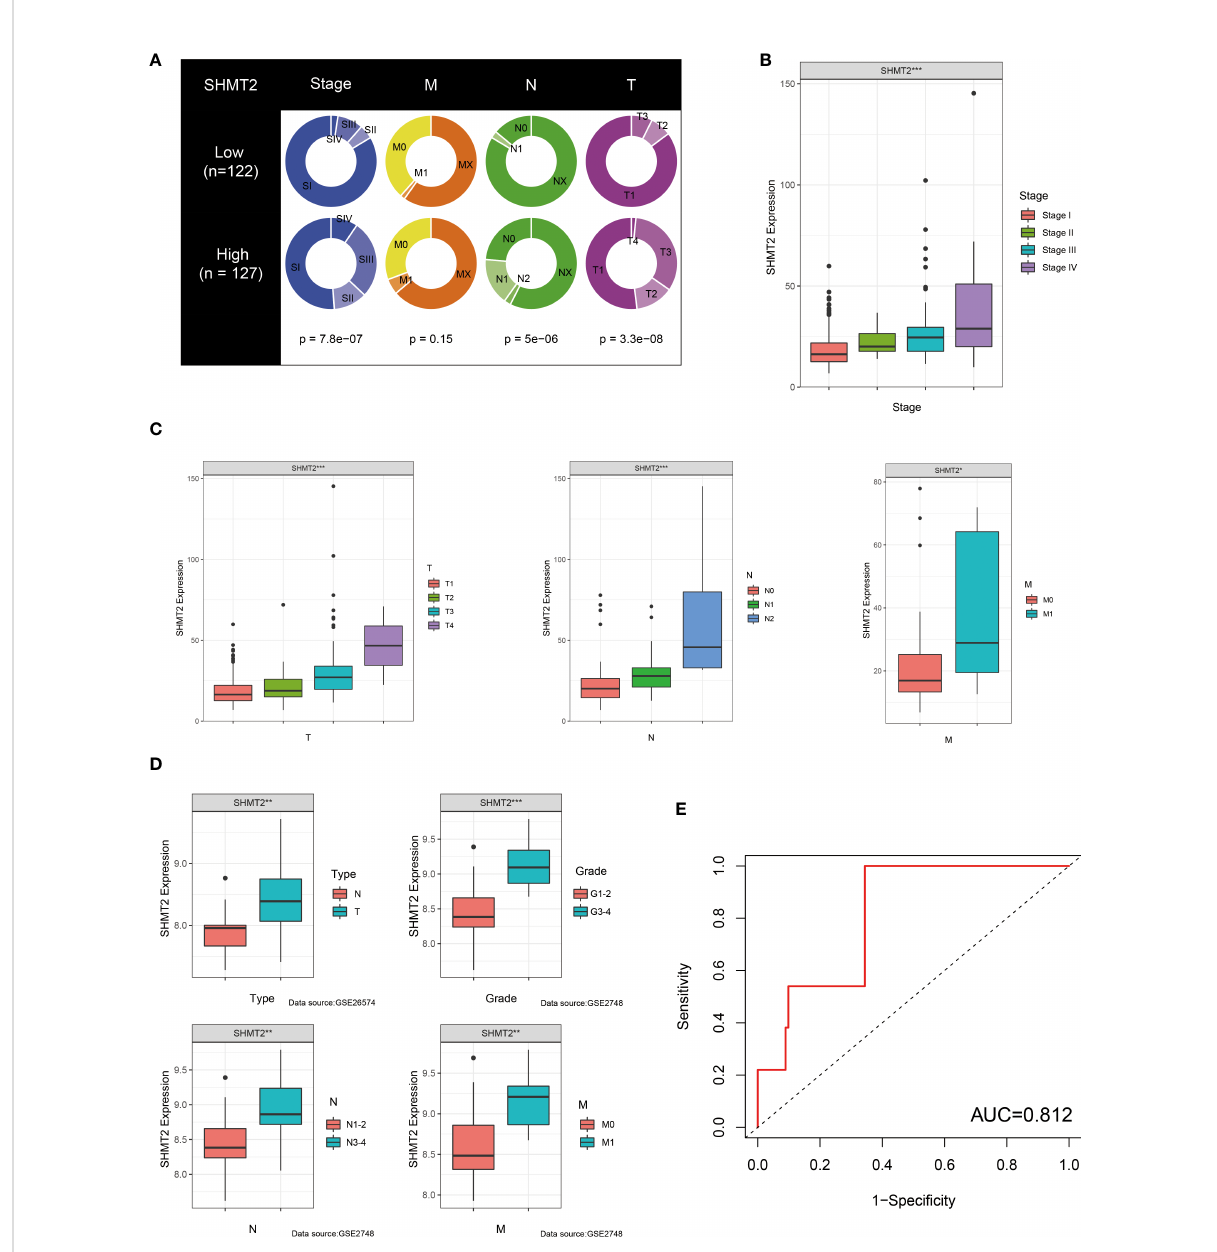
FIGURE 4 SHMT2 expression is upregulated in advanced pRCC. (A) According to data from TCGA, patients with pRCC with high SHMT2 expression tended to be in a more severe disease state, including pathological stage, T stage, and N stage. (B, C) There was a signi fi cant positive correlation between SHMT2 expression and the pathological stage, T stage, N stage, and M stage. (D) Validation of the relationships between SHMT2 expression and clinical parameters in the GSE26574 and GSE2748 datasets. (E) Time-dependent ROC analysis of the TCGA-pRCC set. The AUC value of 0.812 suggested that the forecasting ability of SHMT2 expression was sensitive; *p < 0.05, **p < 0.01, and ***p <